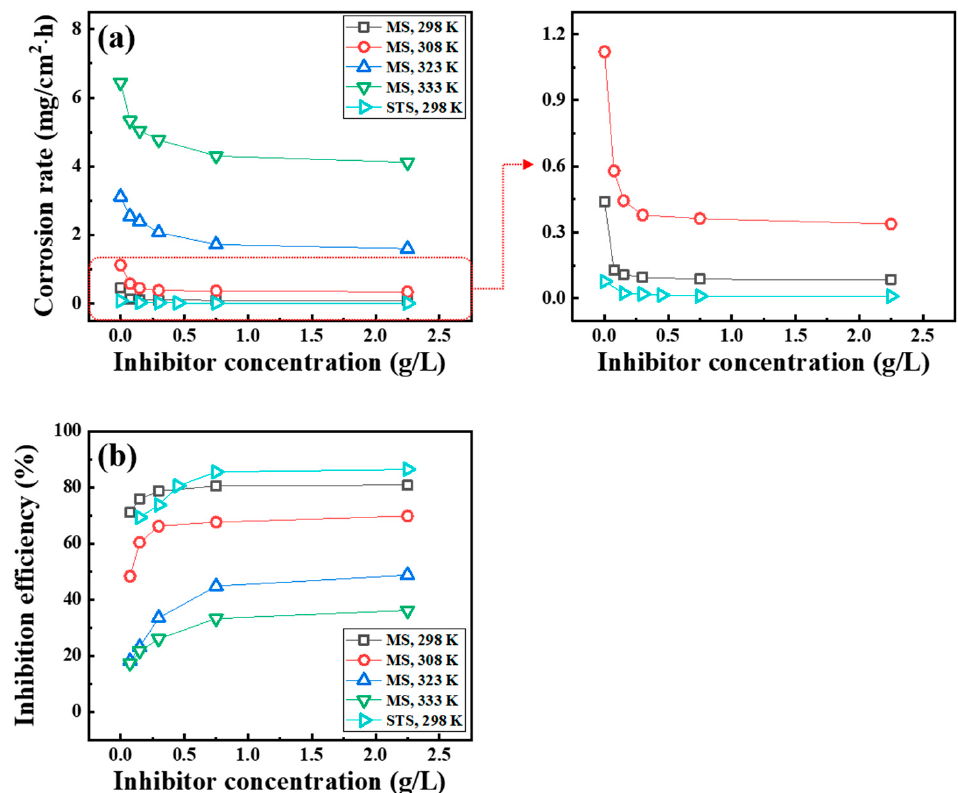
Figure 1. Variation in ( a ) corrosion rate and ( b ) the IE WL for MS and STS specimens obtained from the weight loss test in 1 M HCl solution.